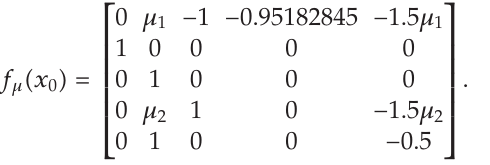
Figure 1: The illustrated conditions (cid:4) T1 (cid:5) – (cid:4) T3 (cid:5) of matrix (cid:4) 4.2 (cid:5) in Example 4.1. The blank region denotes the parameter domain in which all inequalities in the condition (cid:4) T1 (cid:5) hold whereas in the gray region at least one inequality fails. The red heavy solid line and the red break line stand for Δ − respectively. Their intersecting points are marked with P 1 and P 2 . The other lines crossing the blank region consist of the parameter points where the transversality condition (cid:4) T2 (cid:5) or the nonresonance condition (cid:4) T3 (cid:5)